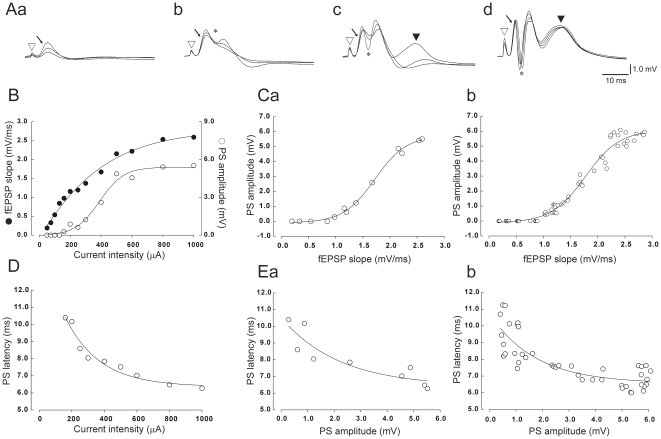
Stimulus intensity-response relationships.A: evoked local field potentials (LFPs) at different stimulus intensities (a: 50, 75 and 100 µA; b: 130, 160 and 200 µA; c: 250, 300 and 400 µA; d: 500, 600, 800 and 1000 µA). Each waveform is an average of 5 LFPs at each stimulus intensity. Inverted open triangles, stimulus artifacts; arrows, field excitatory postsynaptic potentials (fEPSPs); asterisks, population spikes (PSs); inverted filled triangles, positive deflection with a long latency following to clear PS. B: relationships between stimulus intensities and fEPSP slopes (filled circles) or PS amplitudes (open circles). C: relationships between fEPSP slopes and PS amplitudes of averaged (a) and individual (b) data. D: relationships between stimulus intensities and PS latencies. E: a relationship between PS amplitudes and PS latencies of averaged (a) and individual (b) data. Lines in B and C, sigmoid curves produced by Bolzmann fitting; lines in D and E, curves produced by exponential decay fitting.